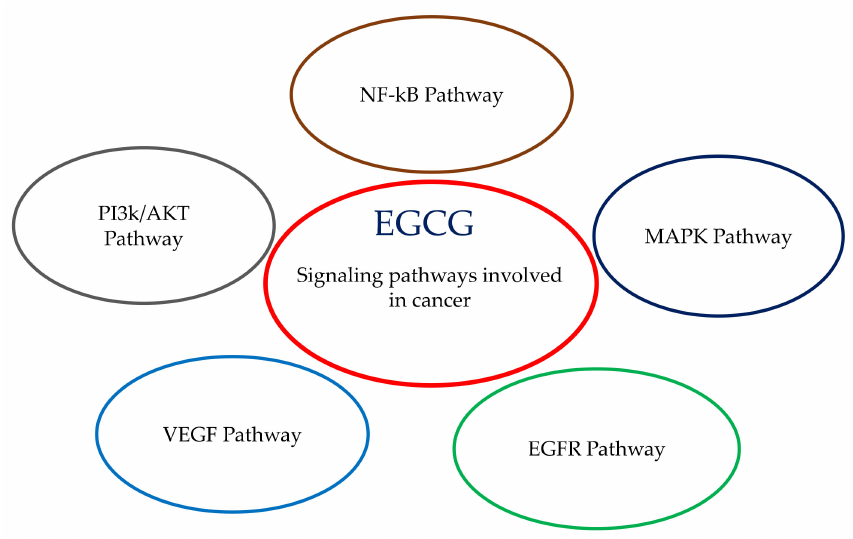
Figure 2. Epigallocatechin gallate (EGCG) involved in the signaling pathways in